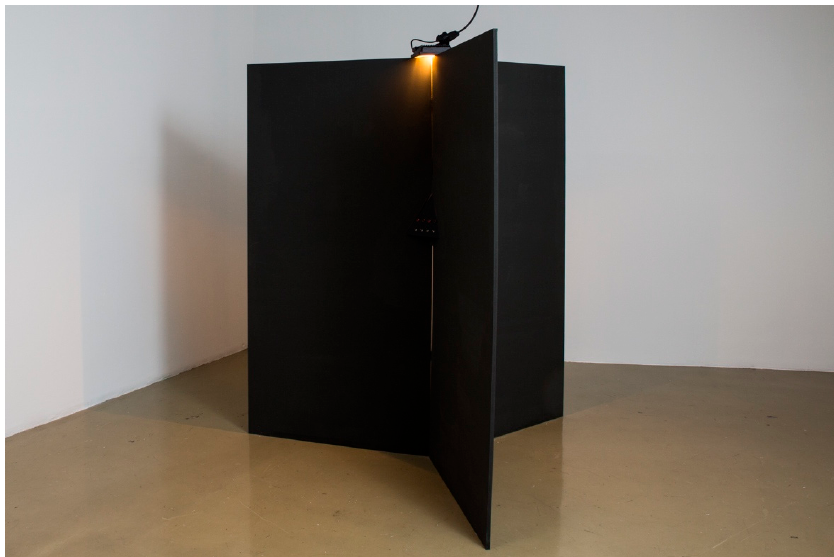
Figure 8. Communications Game in the ‘Primary Codes’ exhibition. 2015. Photo Ernest Edmonds. © Ernest Edmonds.